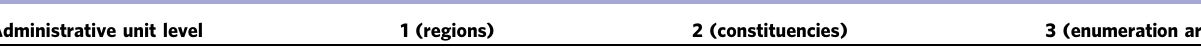
Table 1 Characteristics of administrative levels in